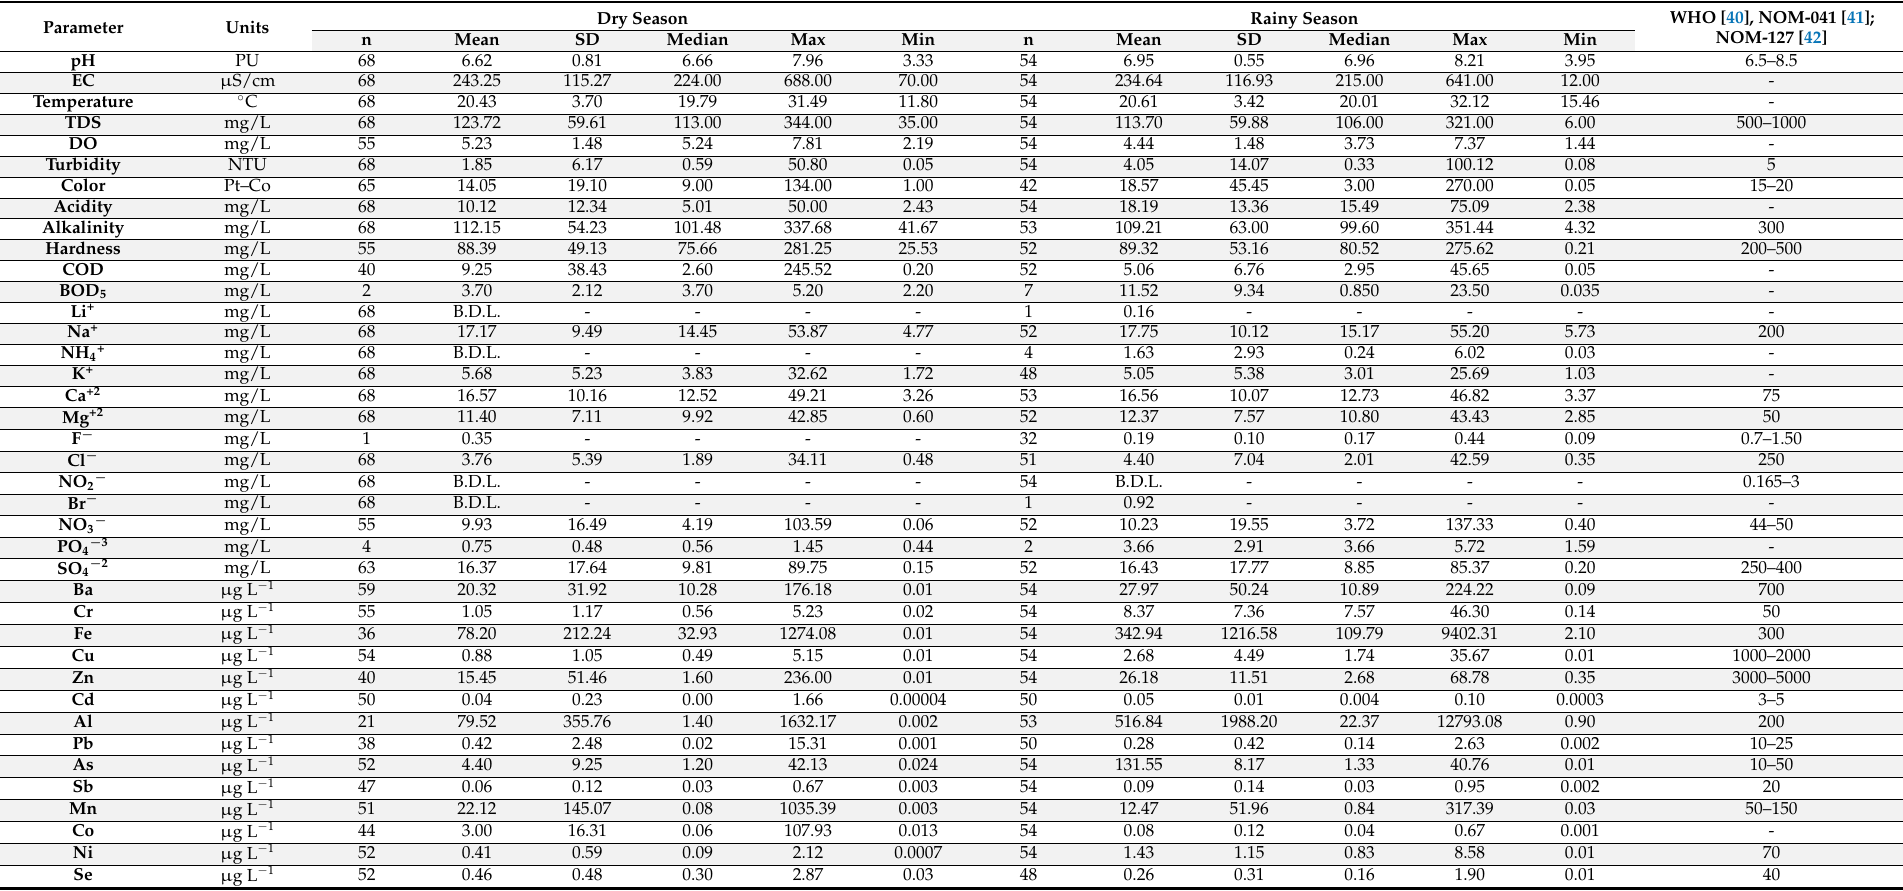
Table 3. Descriptive statistics for water quality parameters by